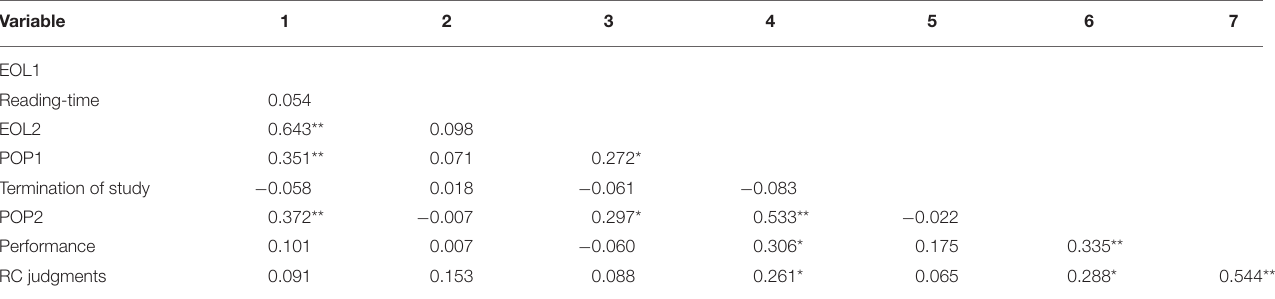
TABLE A1 | Correlations between depend variables across texts and groups ( N = 65).